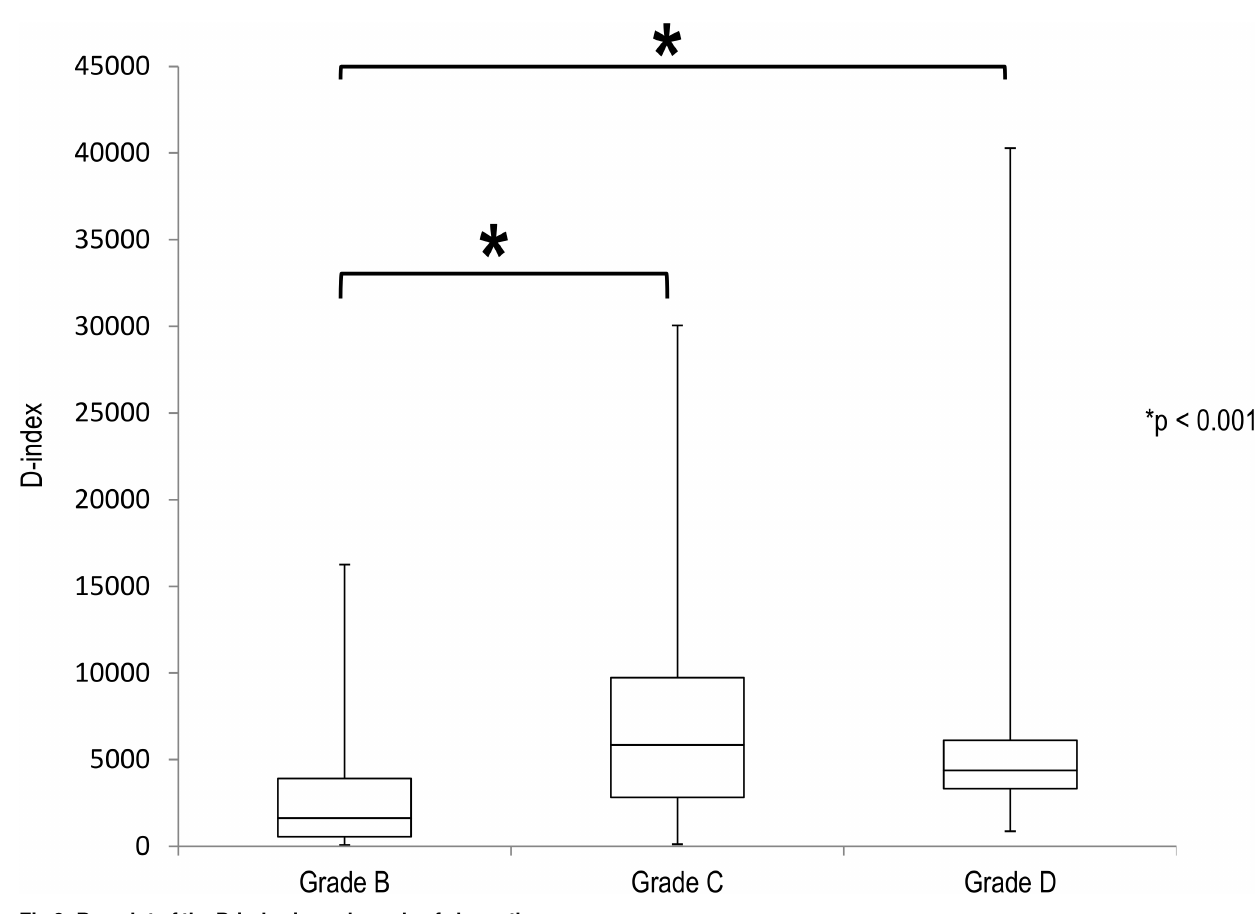
Fig 3. Box plot of the D-index in each grade of chemotherapy.